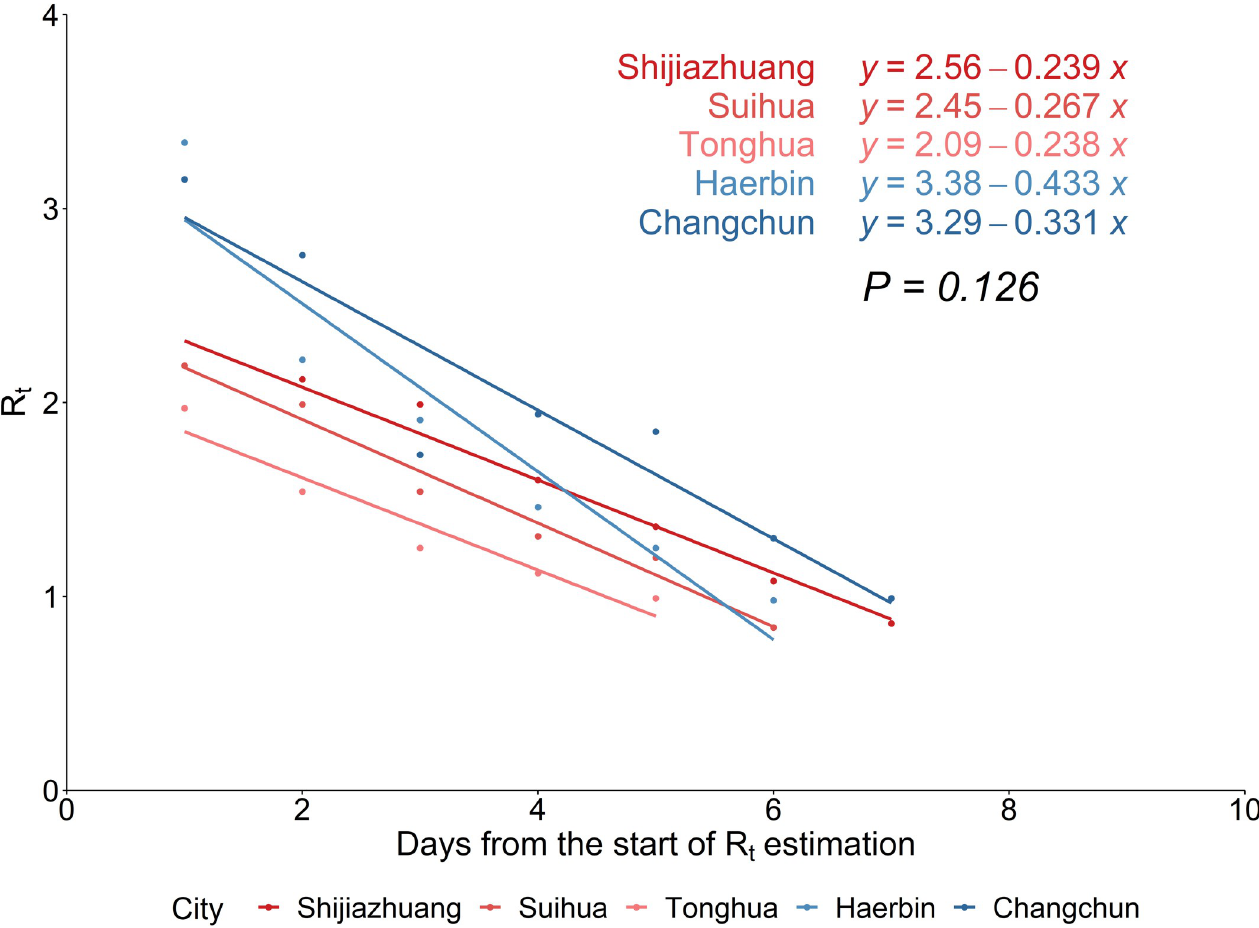
Fig 3. The scatter plots and fitted regression lines of R t estimations in five worst-hit cities in China. The “red” lines represent the cities with “Strong” level NPIs, the “blue” lines represent the cities without “Strong” level NPIs. The equations of linear regression (top right) were fitted from the R of calculation to the first day of R t < 1 in each city. The P value below the equations were the p -value for the hypothesis test based on the analysis of covariance (ANCOVA) evaluating whether the decline in transmission rate was different across cities. R